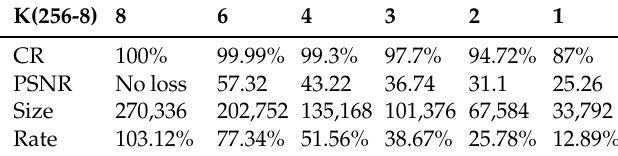
Figure 9. Comparison of execution time and quality of the reconstructed image (a) in Figure 7 under different cutting dimensions with 50% remaining principle components. Table 1. Results of dimension reduction and image reconstruction with proposed method for image (a) in Figure